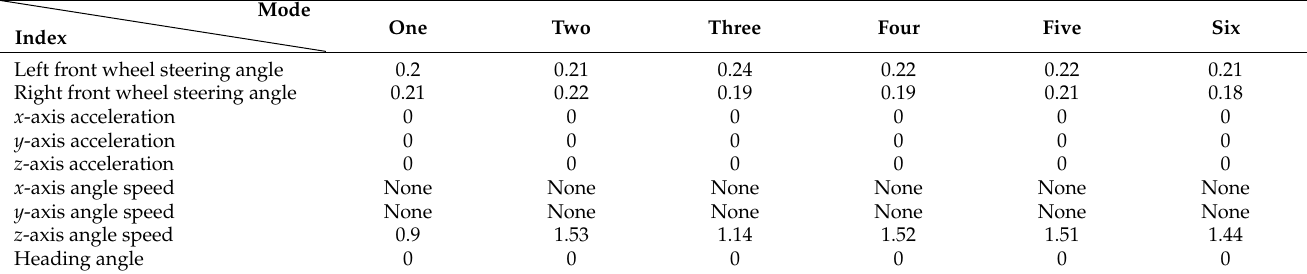
Table 1. Power spectrum frequencies for cement ground parameters.